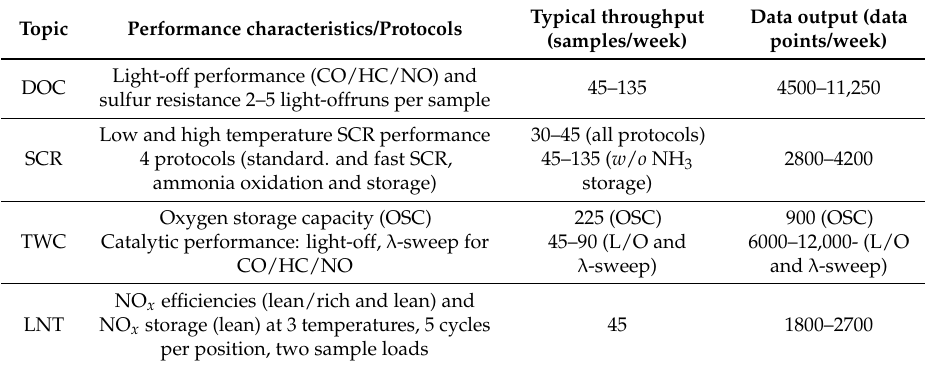
Table 3. Average throughput for different test